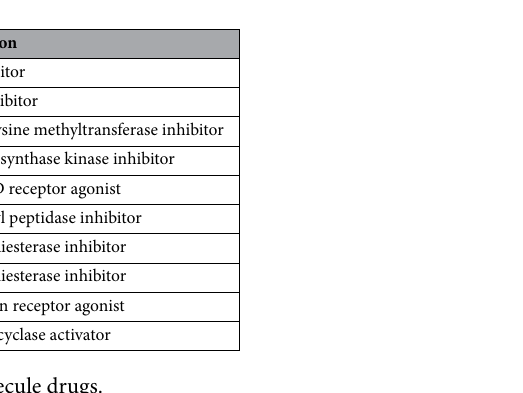
Table 2. Top 10 strongest inhibitory small molecule